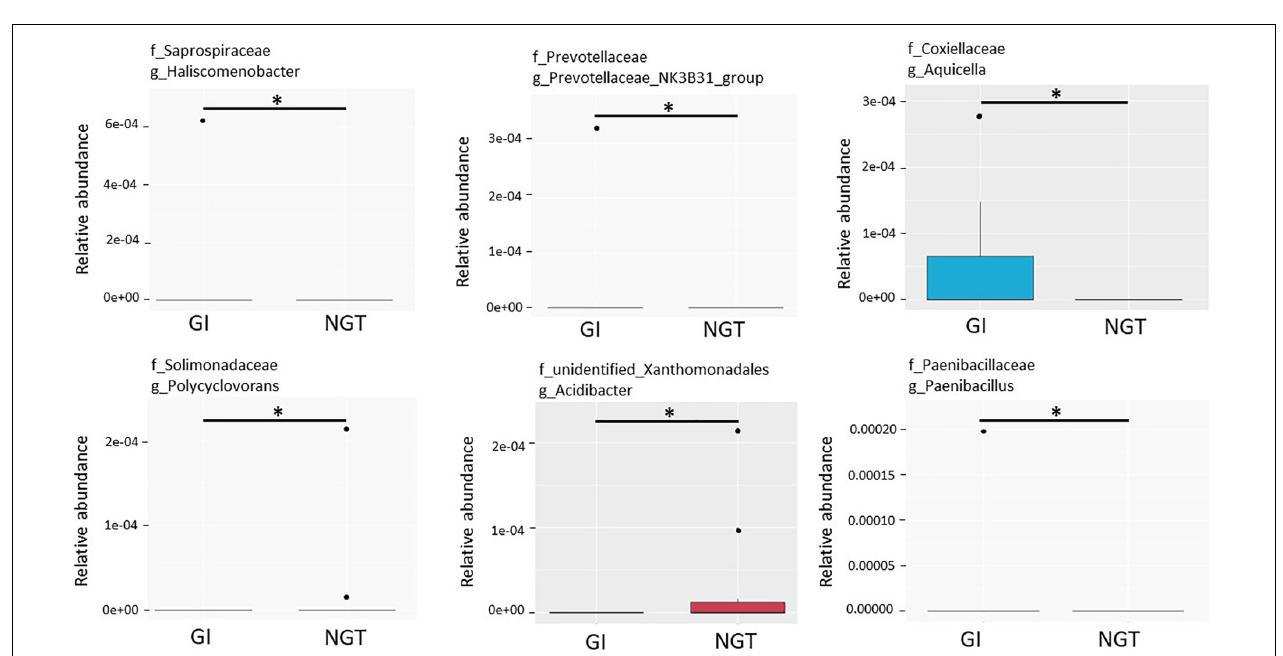
FIGURE 4 | Linear discriminant analysis (LDA) effect size (Lefse) analysis shows differently abundant gut microbial taxa down to genus level between GI and NGT groups. (A) Cladogram represents the predominant gut microbial taxa in the GI and the NGT groups. The point in the center of the cladogram reflects the root of the tree (bacteria) while the innermost ring reflects the phylum level. Subsequent outer rings reflect the next taxonomic level (i.e., class, order, family, and genus). (B) The histogram represents the LDA score computed for each differently abundant gut microbial taxon between GI and NGT groups. The α -value < 0.05 and LDA score ≥ 2.0 were considered statistically significant.